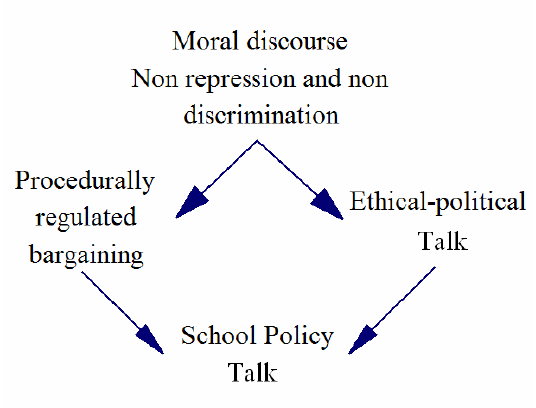
Figure 2 : Gutmann’s model of deciding curriculum